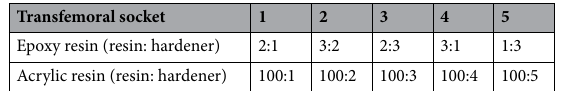
Table 1. Resin to Hardener